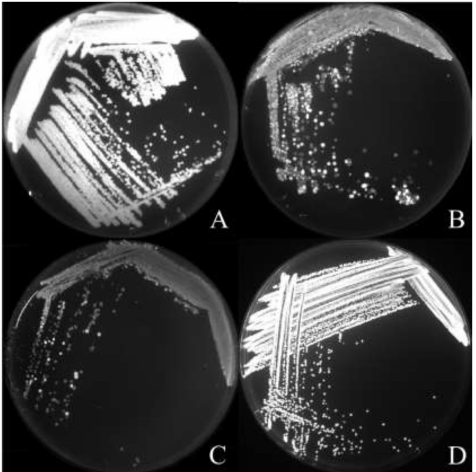
Figure 4. Comparison of green fluorescence protein (GFP) fluorescence of S. maltophilia. Smal-007 tagged by plasmid ( A, B, C ) and integration on the genome ( D ). A: Smal-007GFP, S. maltophilia Smal-007 tagged by gfp-containing plasmid at the first streaking. B: Smal-007GFP at the second streaking. C: Smal-007GFP at the third streaking. D: Smal-007GFPI, S. maltophilia Smal-007 with integrated gfp at the third